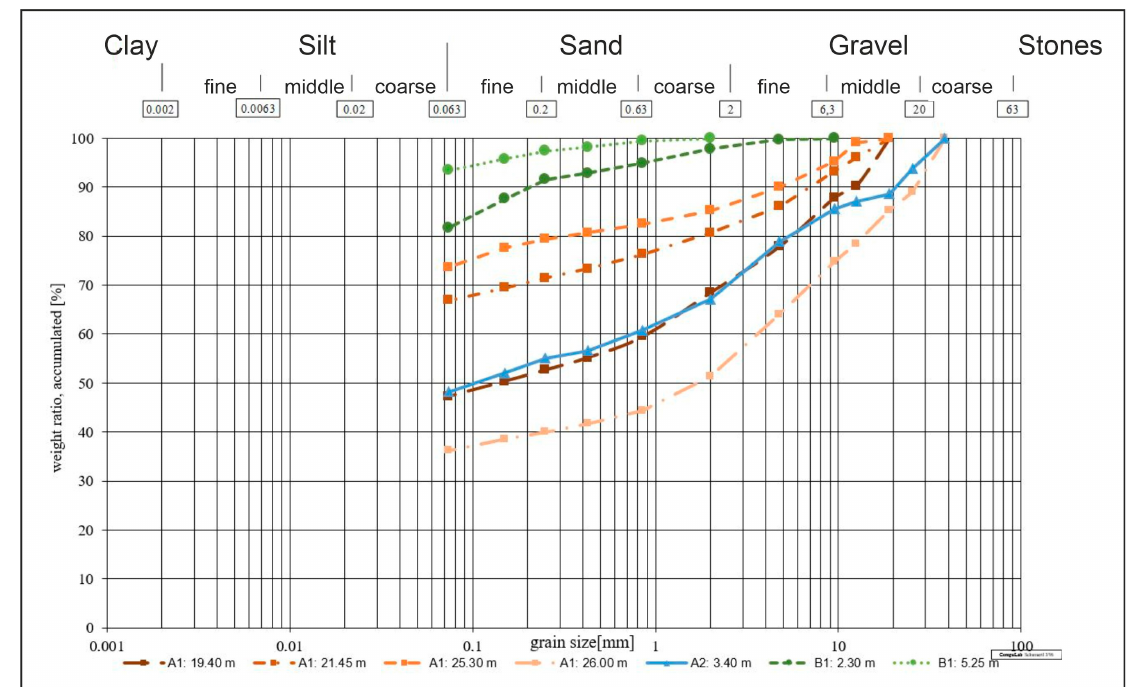
Figure 10. Grain size distribution of all drillings depicted according to DIN EN ISO 14688-1 (2020) [30].